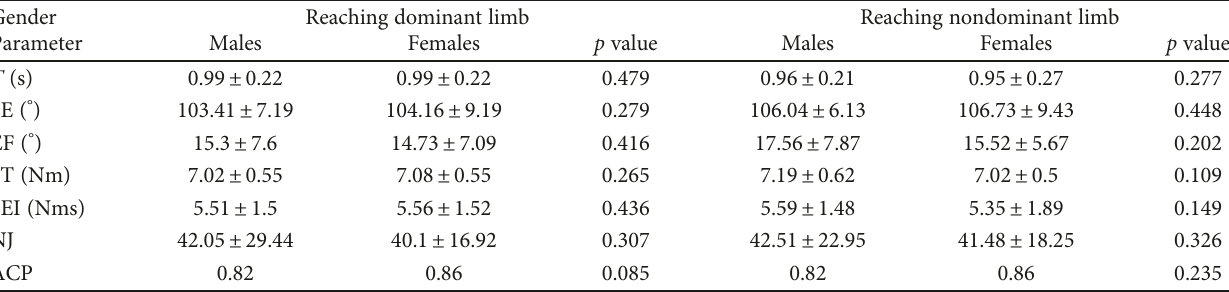
Table 3: Gender subsets: reaching.